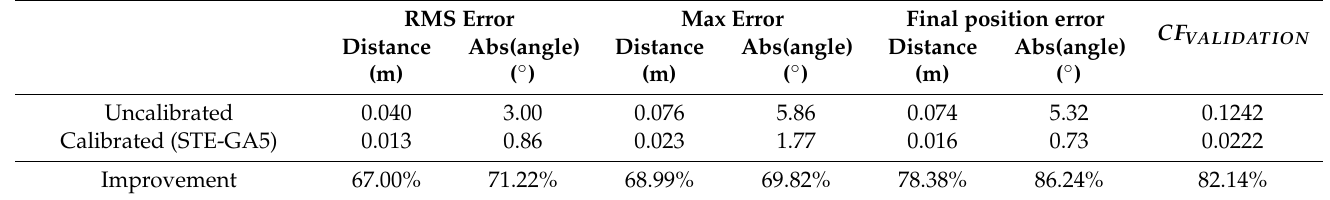
Table 6. Summary of the average trajectory errors obtained with the uncalibrated and calibrated kinematic